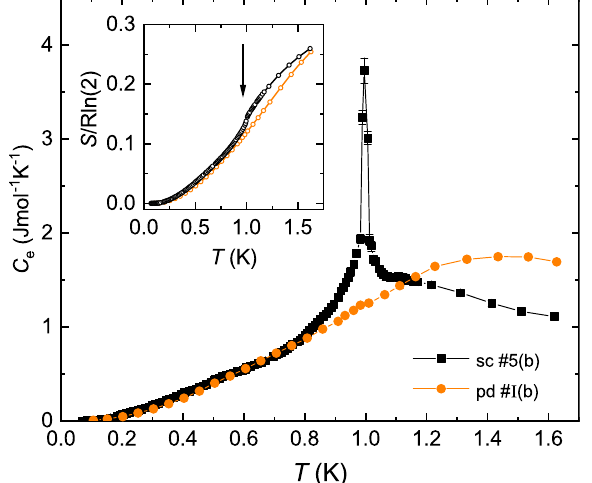
Fig. 1 Temperature dependence of the electronic speci fi c heat of PbCuTe 2 O 6 . Electronic speci fi c heat of single crystal sc #5(b) (black squares) and a pressed-powder sample pd # Ι (b) (orange spheres).